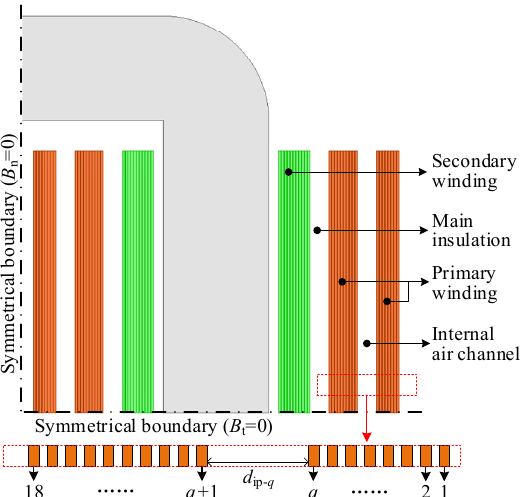
Figure 9. Winding model with non-uniform arrangement of conductor layers.